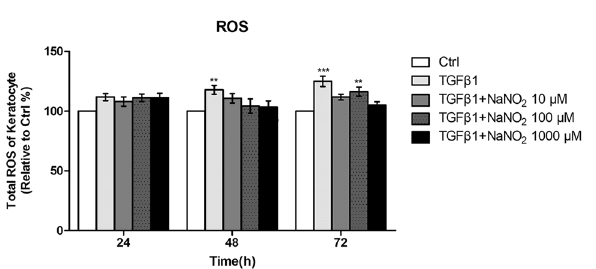
Figure 5. Total reactive oxygen species (ROS) production was measured in keratocytes after 24, 48 and 72 h culture with TGFβ1 (10 ng/mL). Slight increase of total ROS was observed in TGFβ1 (10 ng/mL) stimulated keratocytes compared to control keratocytes (Ctrl). Treatment with sodium nitrite (10, 100 or 1000 μM) alleviated total ROS production in stimulated keratocytes. **p < 0.01, ***p <